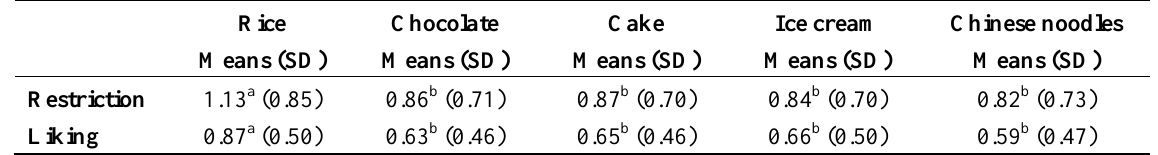
Table 3. Means (SD) of the distances between the observed values and the regression line for the five items with the highest mean craving scores in the scatter